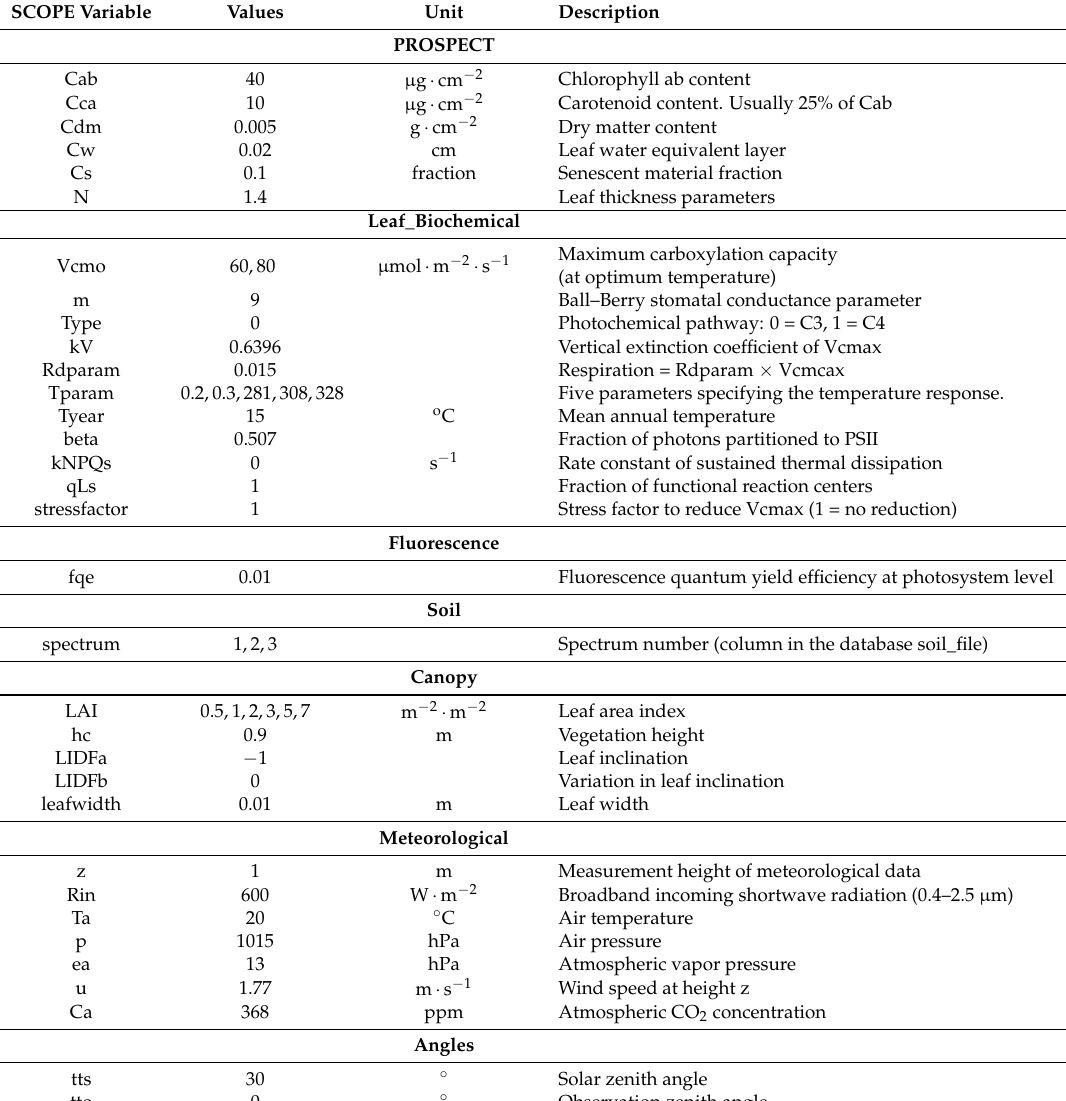
Table A1. Values of the input parameters of the SCOPE model used in the